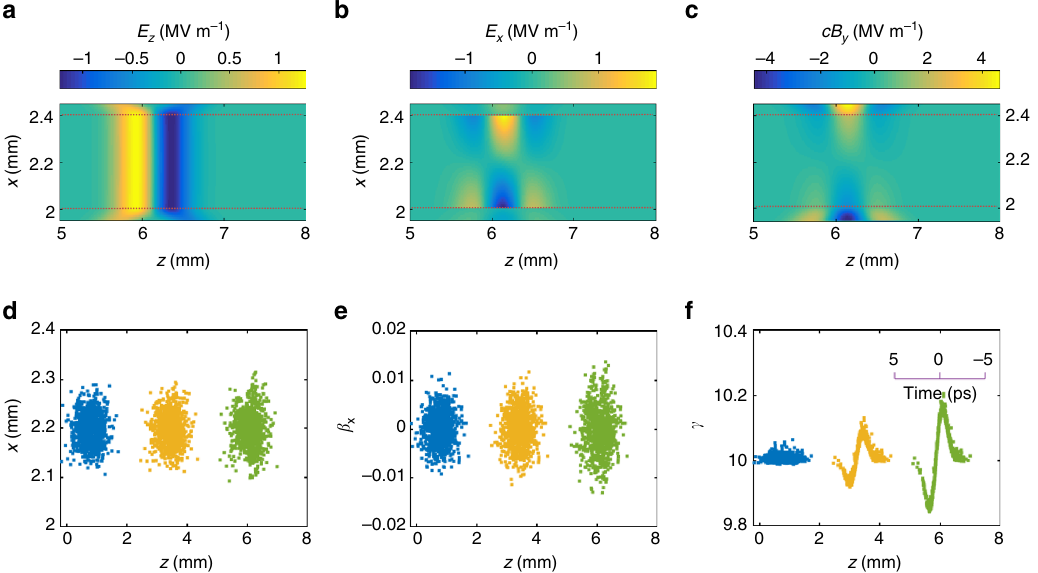
Fig. 4 Particle acceleration in a paired travelling source structure. a – c longitudinal electric fi eld ( E z ) and transverse electric and magnetic fi eld components ( E x , H y ) at t = 18 ps for a 500 fs, bipolar terahertz source with peak longitudinal fi eld strength of 10 MVm − 1 generated in each crystal. Nonlinear dielectric media are present at x < 2.0 mm and x > 2.4 mm, with a vacuum region in between. The vacuum/dielectric interfaces are marked with dotted lines . The nonlinear interaction in each crystal generates identical longitudinal fi eld E z and opposite polarity transverse fi elds E x , B y . d – f Transverse position, angle and energy respectively for 1000 electrons after acceleration in a 15 mm structure as a function of particle position in the bunch; particles enter the structure at 5.2 MeV/c, with 500 fs rms duration with 100 μ m rms diameter. The blue , yellow and green particle distributions correspond to those at times 0, 8.8 and 17.7 ps, respectively. For a 5 MeV beam energy with particle velocity β / c = 0.995, there is negligible velocity spread within the bunch, allowing the behaviour of shorter duration bunches to be inferred directly from the corresponding temporal slice in the particle distributions shown